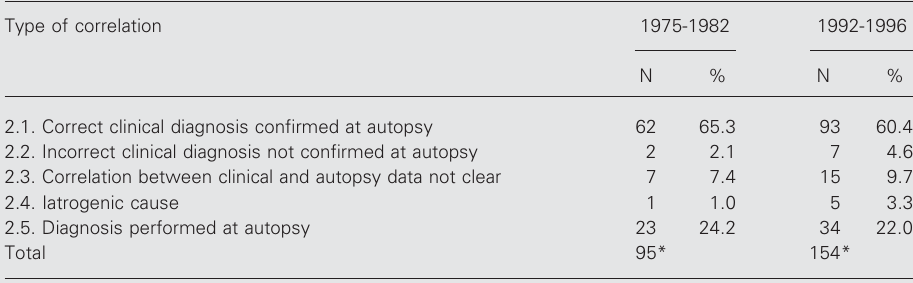
Table 2. Terminal causes of death: correlation between clinical diagnoses and autopsy findings during two different periods (Faculdade de Medicina de Botucatu, São Paulo, Brazil). Type of